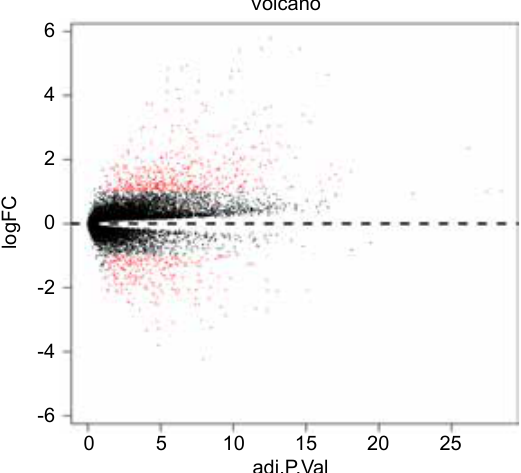
Figure 2 Volcano plot of the 20460 genes. Red dots represented the 784 differentially expressed genes (DEGs) and black dots represented the remaining genes with no different